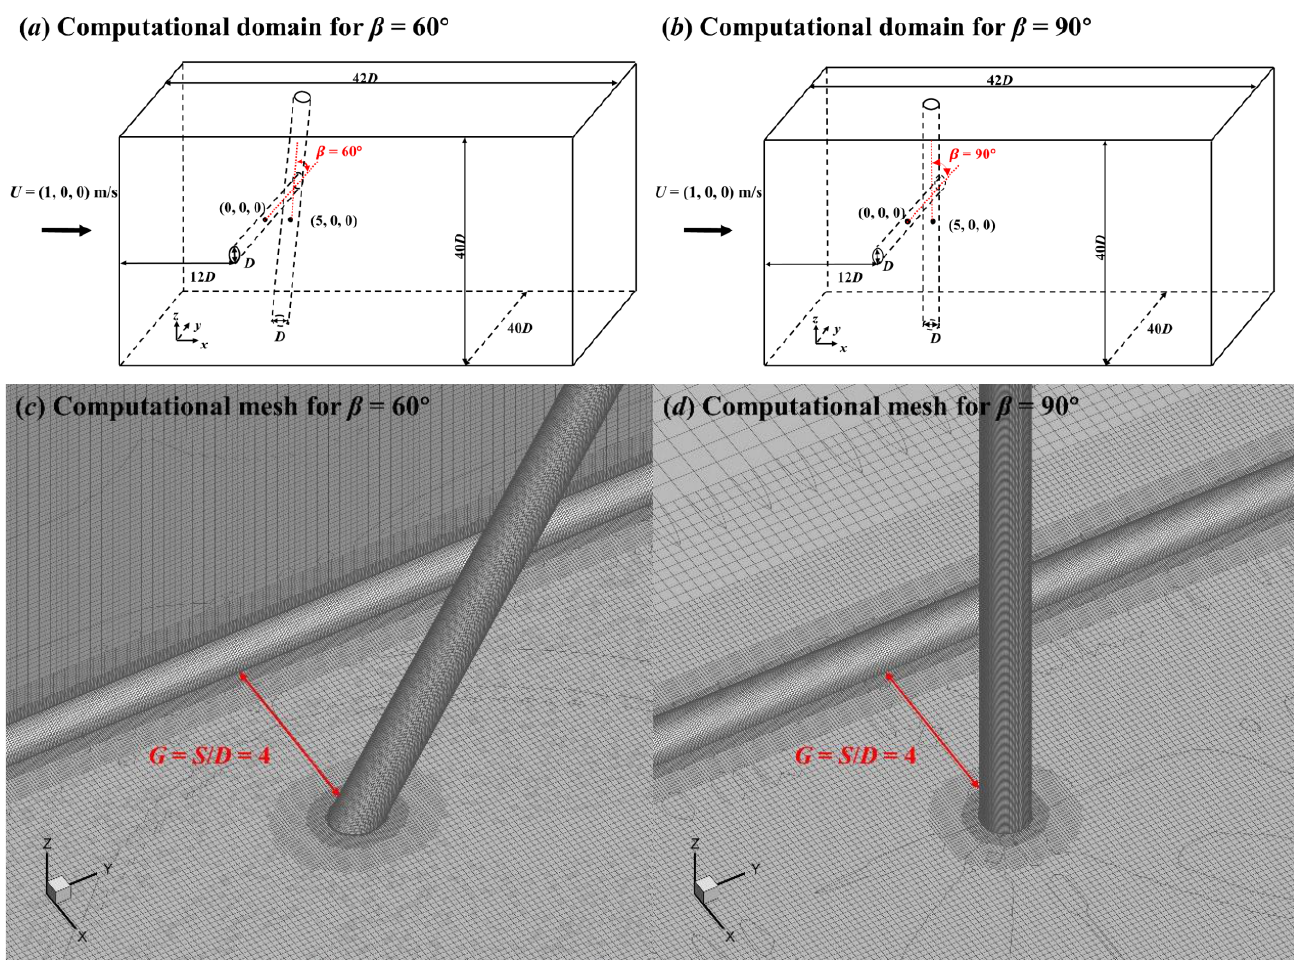
Figure 2. Rectangular computational domain and computational mesh for the two crossing circular cylinders in 60° ( a , c ) and 90° ( b , d ) arrangements with G = 4.